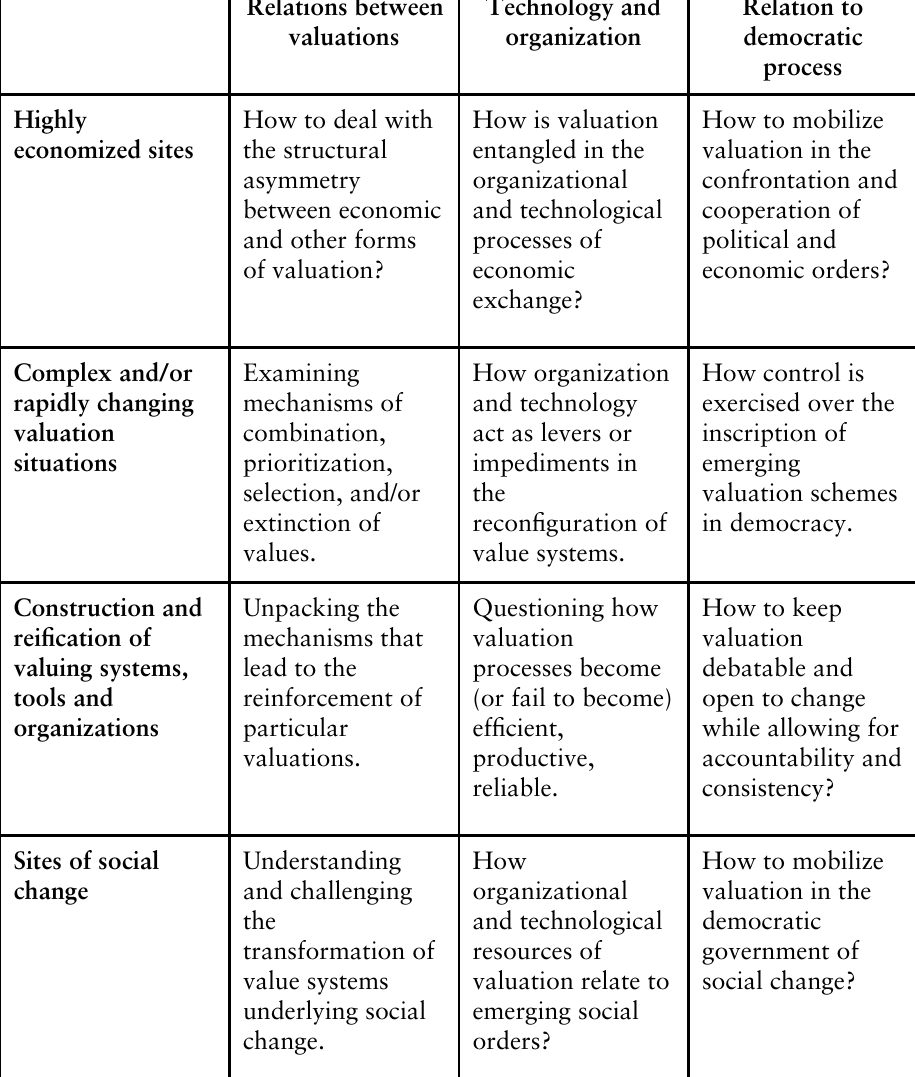
Table 1. Specific objects of interests/challenges emerging from the combination of issues and sites for studying